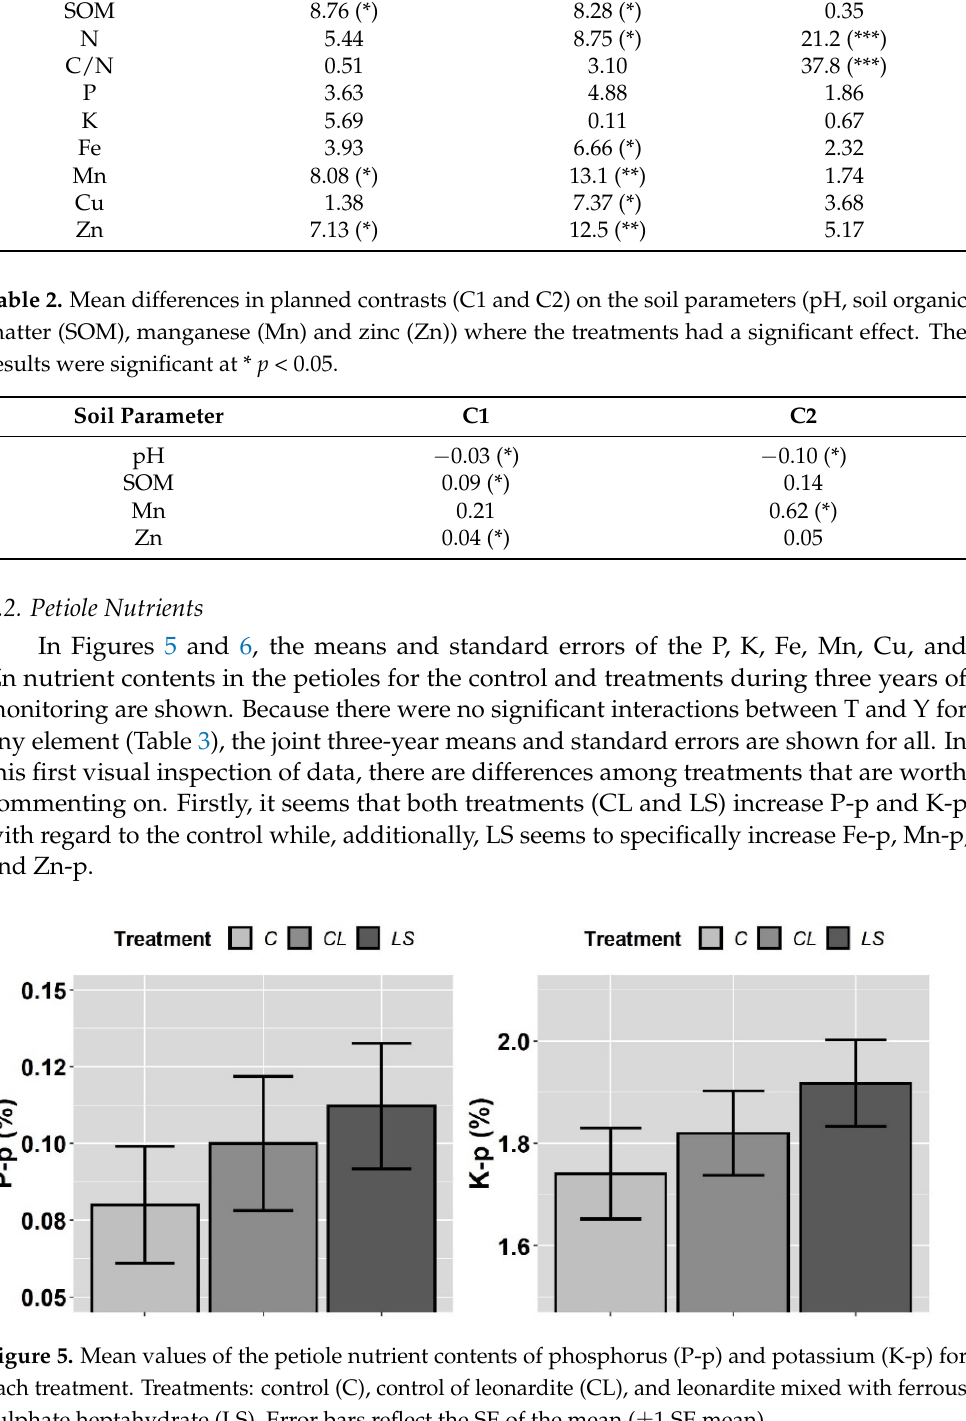
Figure 6. Mean values of the petiole nutrient contents of iron (Fe ‐ p), manganese (Mn ‐ p), copper (Cu ‐ p) and zinc (Zn ‐ p) for each treatment. Treatments: control (C), control of leonardite (CL), and